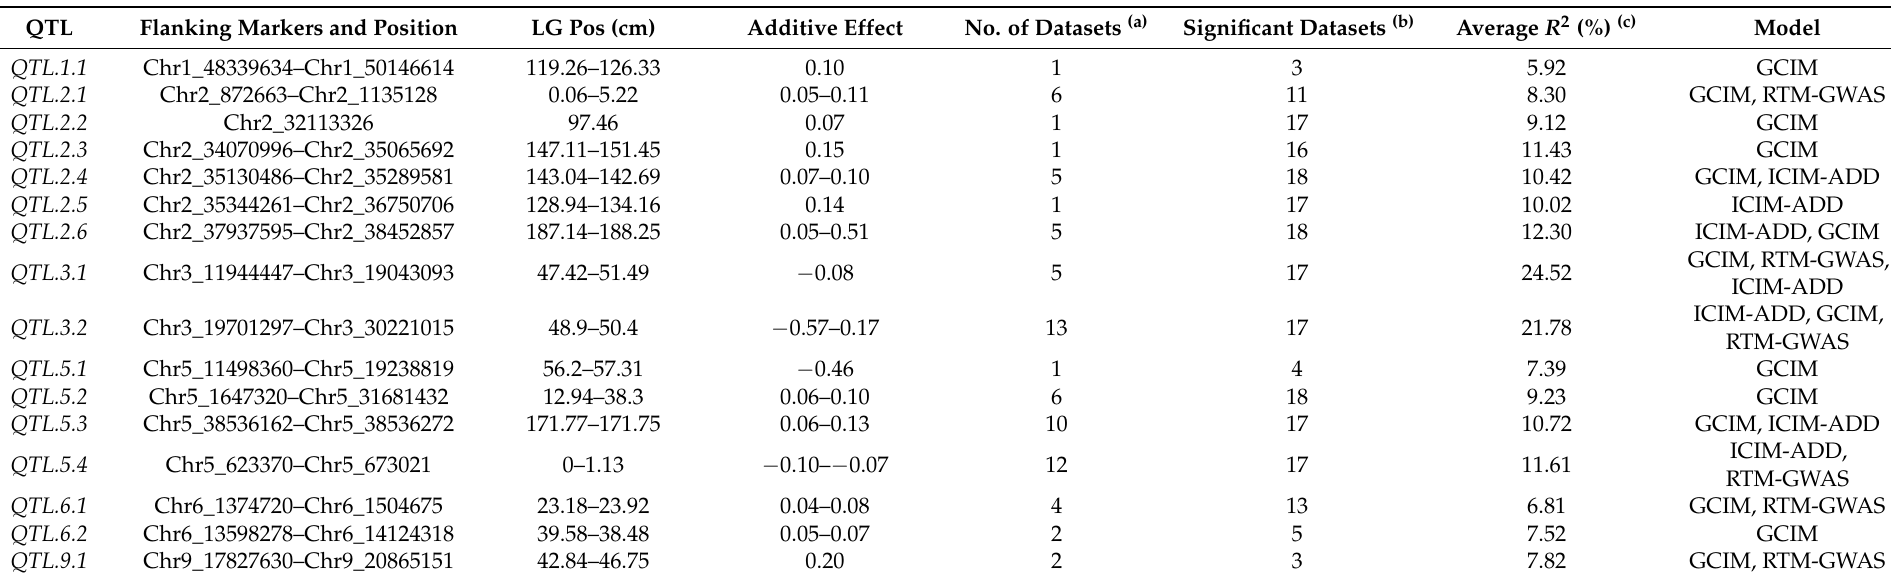
Table 3. Sixteen quantitative trait loci (QTL) detected from the recombinant inbred line (RIL) population of 138